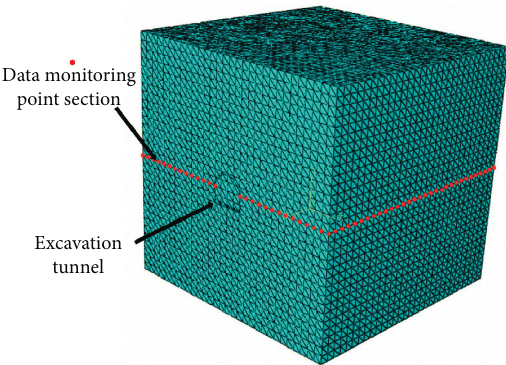
Figure 13: Three-dimensional computational mesh of rock